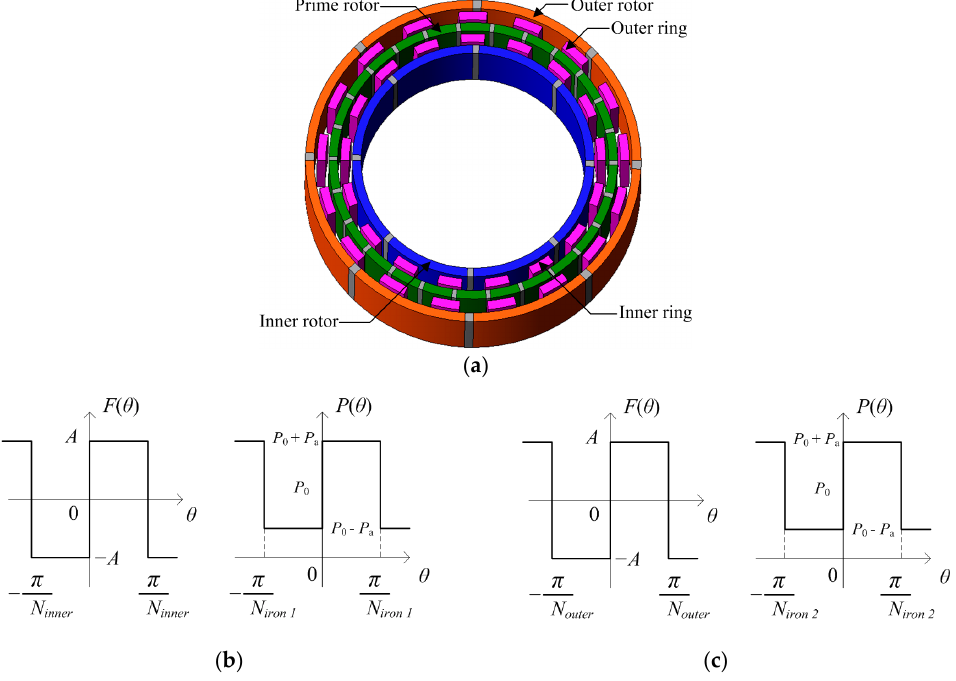
Figure 3. Structure of magnetic gear with three rotors: ( a ) Configuration of the triple-rotor magnetic gear; ( b ) Magnetomotive force and permeance distribution of the inner gear; ( c ) Magnetomotive force and permeance distribution of the outer gear.